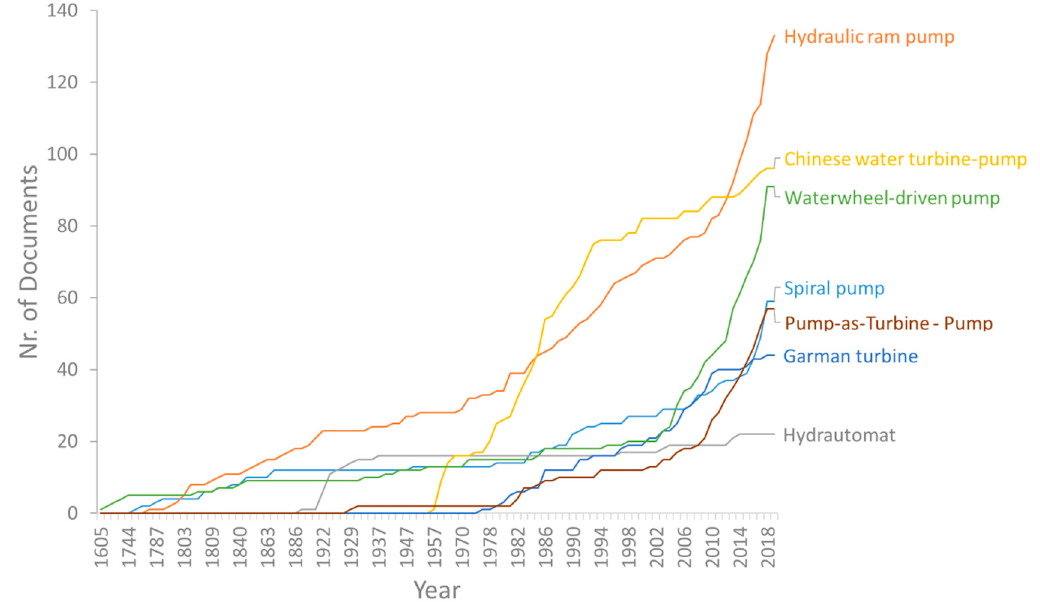
Figure 12. Noncumulative number of selected documents published over time. The different colored lines depict the running total of documents produced per technology per year. Only the most noticeable ones are represented.